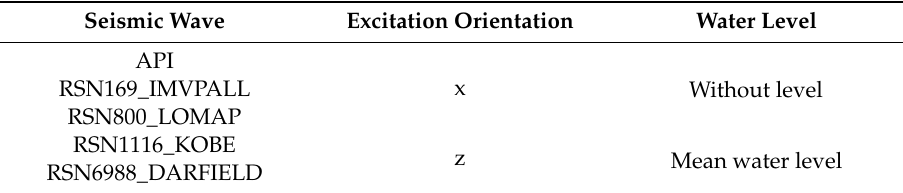
Table 5. The seismic loads in the experiment.